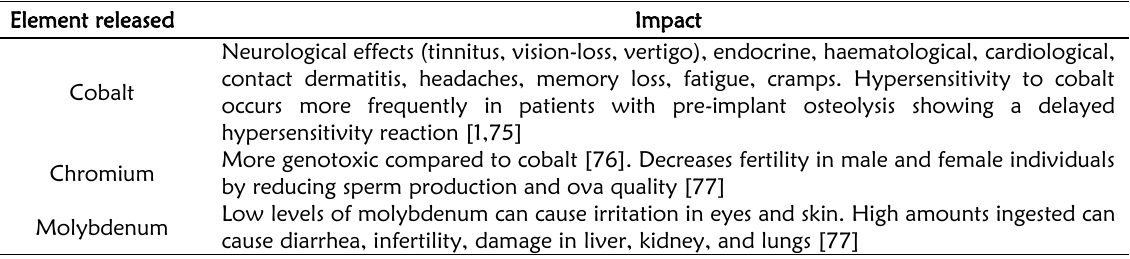
Table 3: Effects of the elements released from Co-Cr prosthesis